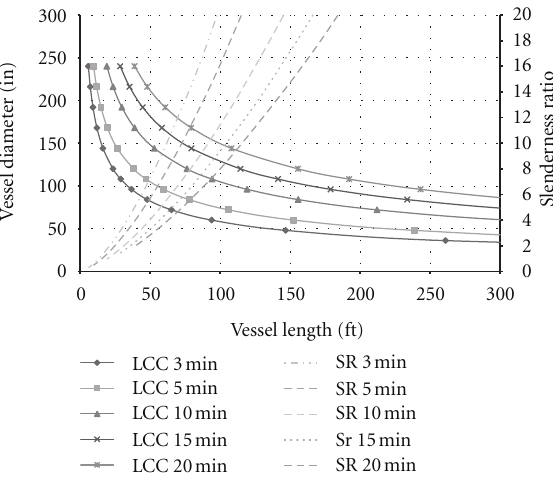
Figure 6: Modified Arnold-Stewart’s method for peak flow rates.